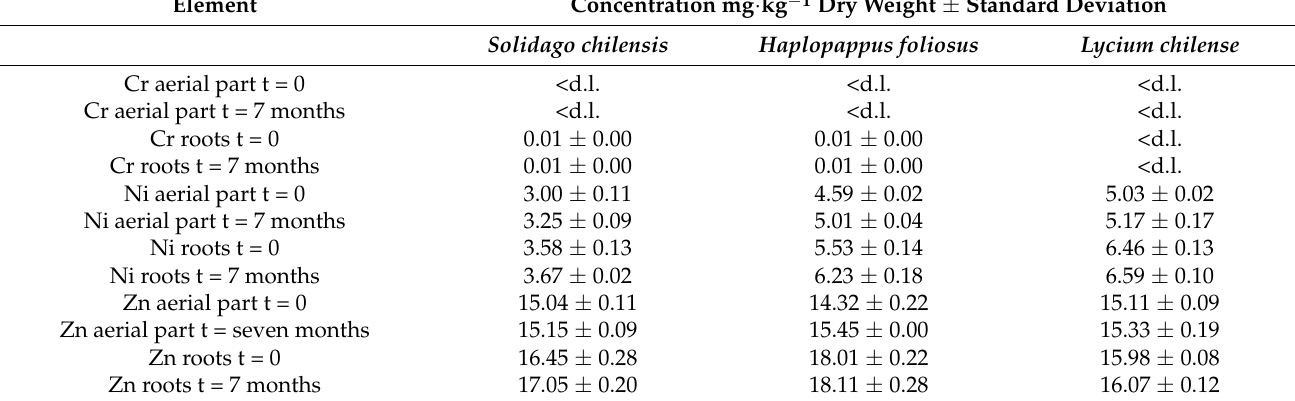
Table 2. Blank samples. Initial and final